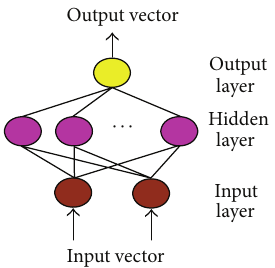
Figure 4: Structure of BPNN.